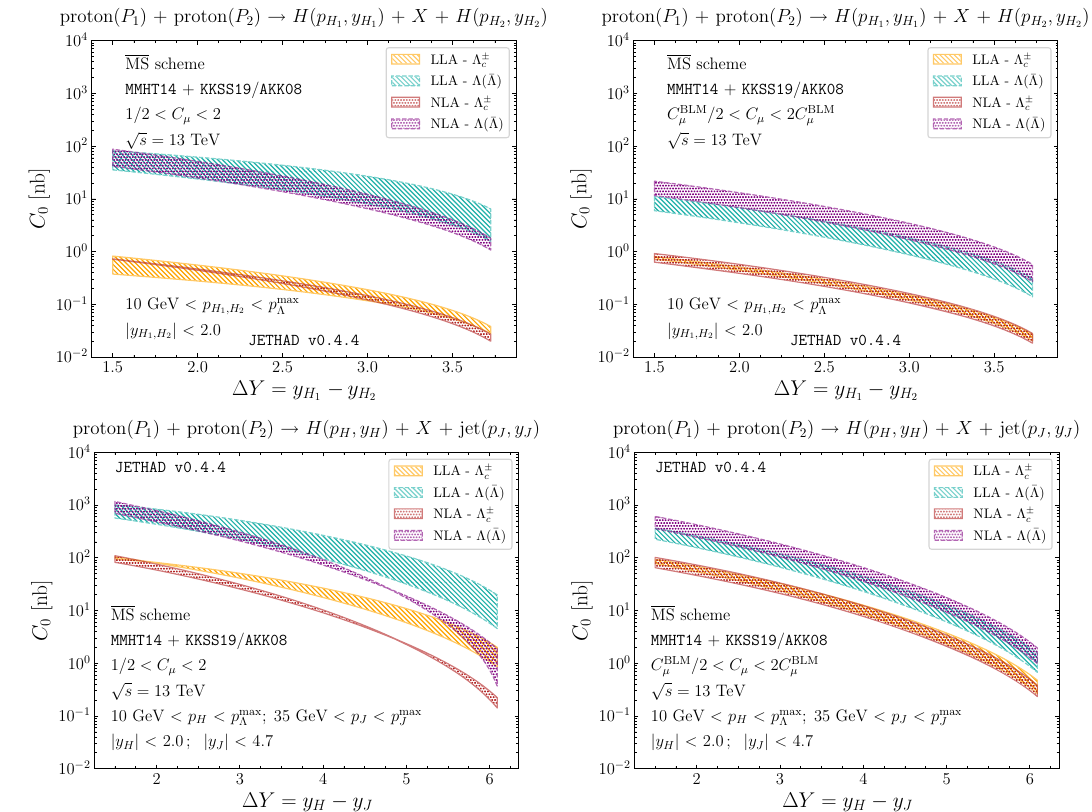
Fig. 3 Behavior of the ϕ -summed cross section, C 0 , as a function of scalevariationandnumericalintegrations.Predictionsfor (cid:2) c emissions (cid:5) Y , in the double (cid:2) (cid:2) are compared with configurations where (cid:2) hyperons are detected. √ c (upper) and in the c plus jet channel (lower), at s = 13 naturalscales(left)andafterBLMoptimization(right),andfor TeV. Error bands provide with the combined uncertainty coming from